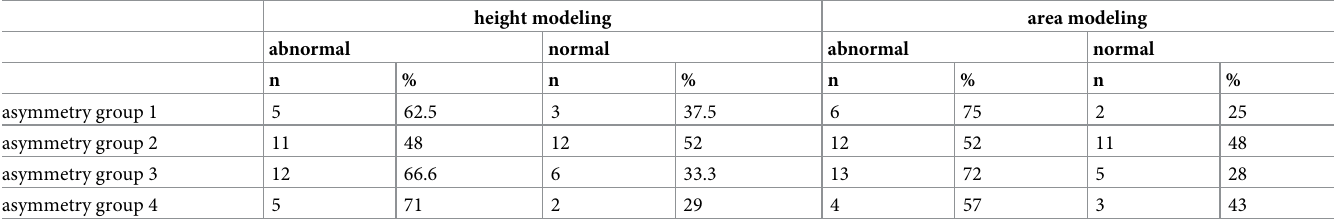
Table 2. Condyle modeling proportions in